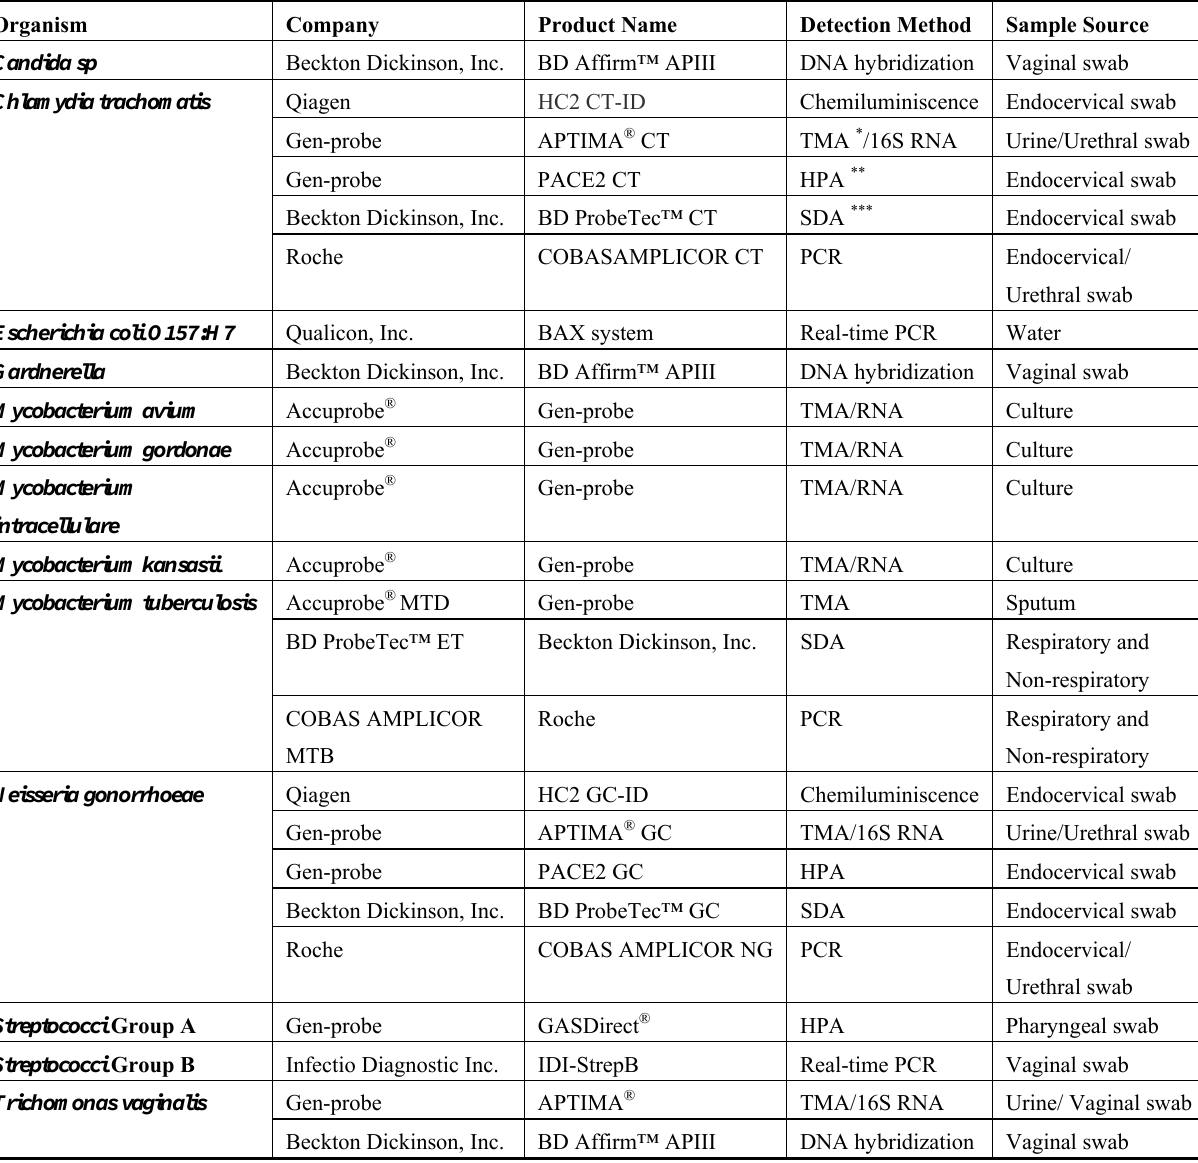
Table 1. A list of commercially available nucleic acid-based biosensors for pathogen detection with their mode of detection and the sample